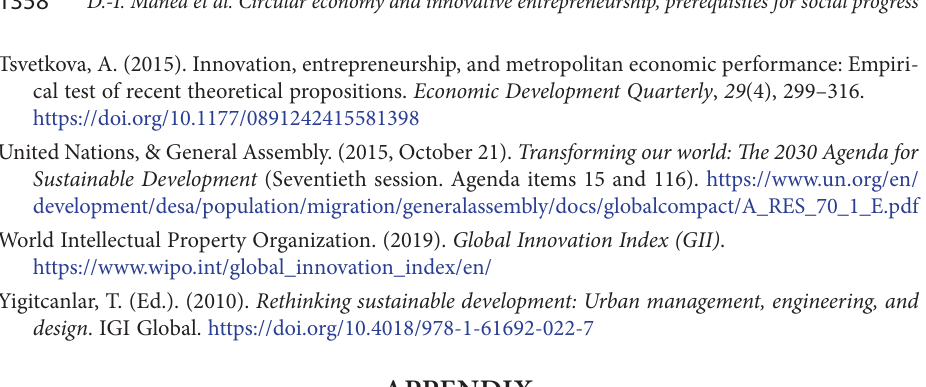
Table 1. Component Score Coefficient Matrix and Coefficients index (source: created by the authors) Component